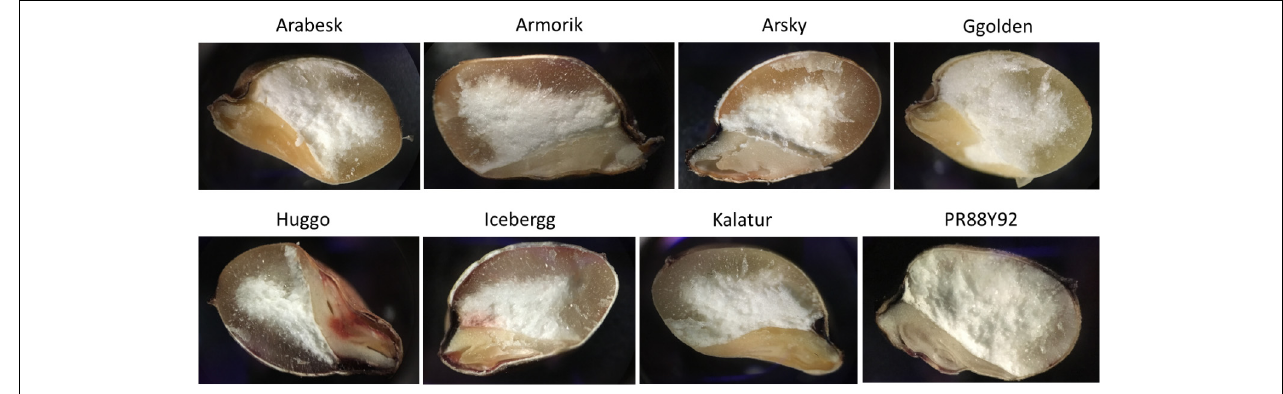
FIGURE 2 | Microscope (Olympus BX51) shows the images of the longitudinal section of the kernels of the eight sorghum varieties used in this study. Magnification power: 4 × . The average kernel length was between 3.9 and 4.7 mm ( Supplementary Table 1 ).